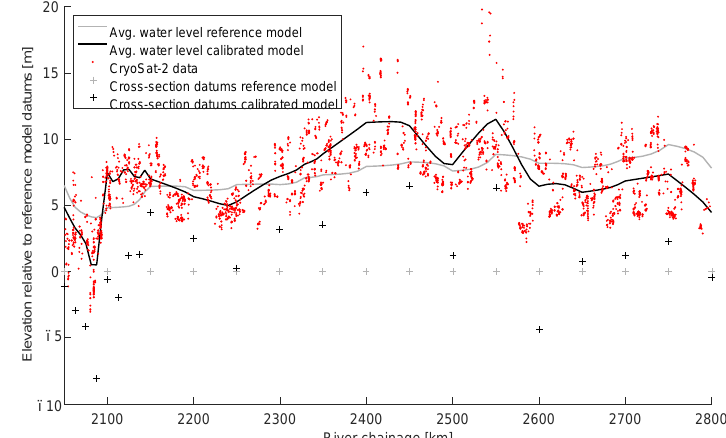
Figure 7. Result of cross-section calibration step 1 for the Assam Valley for the period 2010 to 2013. All levels are shown relative to the reference model’s cross-section datums based on the SRTM DEM.